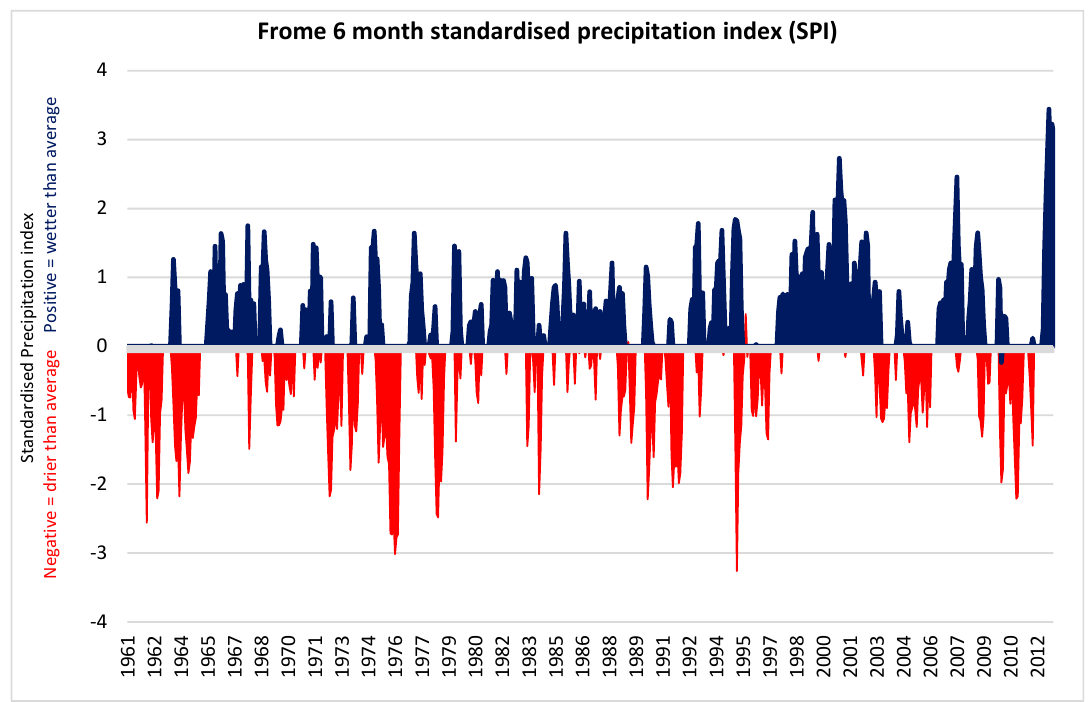
Figure 8. Six months standardized precipitation index (SPI) of the Frome catchment from 1961 to 2012.